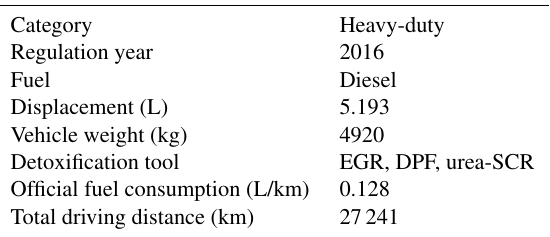
Table 1. Specifications of the vehicle tested in this study (DPF sig- nifies diesel particulate